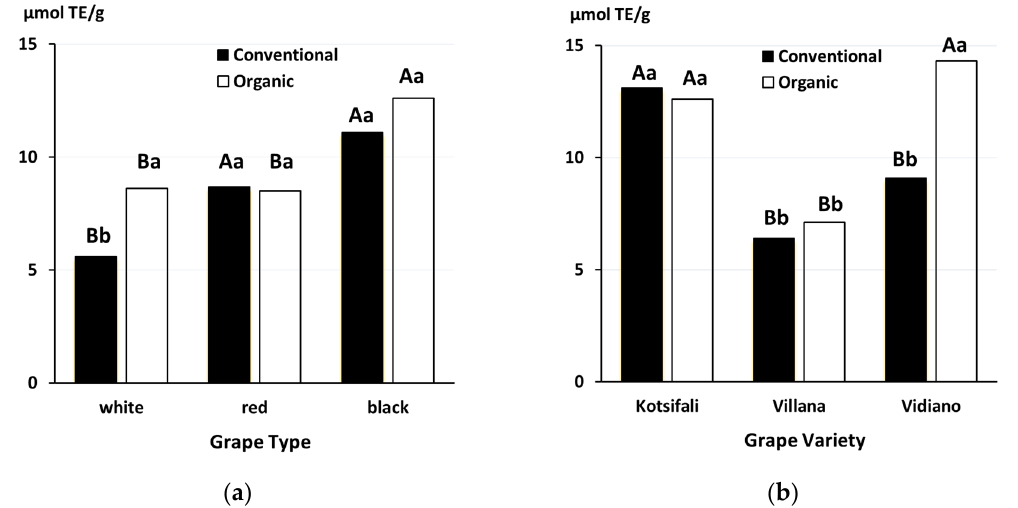
Figure 10. Effect of organic and conventional production methods on antioxidant activity/capacity (TEAC) in ( a ) white, red and black table grape analyses, as part of a UK retail survey, data from [12] (2-factor ANOVA detected a significant interaction ( p = 0.025) between grape type and production systems) and ( b ) grapes of three indigenous, traditional grape varieties analyzed as part of a farm survey in Crete, Greece, data from [19] (2-factor ANOVA detected a significant interaction ( p = 0.016) between grape variety and production systems). Means with the same capital letter for the same production system and means with the same lower-case letter for the same grape type or variety are not significantly different according to Tukey’s contrasts ( p <